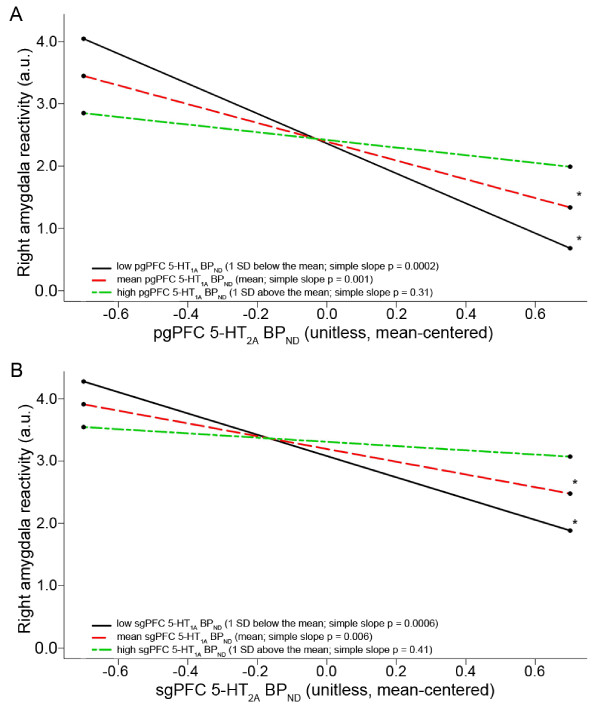
5-HT1A BPND significantly moderated the correlation between 5-HT2A BPND and right amygdala reactivity. (A) pgPFC 5-HT1A BPND moderated the correlation between pgPFC 5-HT2A BPND and right amygdala reactivity. Lines indicate simple slope between pgPFC 5-HT2A BPND and right amygdala reactivity at three arbitrarily chosen pgPFC 5-HT1A BPND values: low (1 SD below mean (-1 SD), solid black line), mean (equivalent to mean, red dotted line) and high (1 SD above mean (+1 SD), green dotted line). (B) sgPFC 5-HT1A BPND significantly moderated the association between sgPFC 5-HT2A BPND and right amygdala reactivity. Lines indicate simple slope between sgPFC 5-HT2A BPND and right amygdala reactivity at three arbitrarily chosen sgPFC 5-HT1A BPND values: low (-1 SD, solid black line), mean (red dotted line) and high (+1 SD, green dotted line). *Indicates simple slope, P < 0.05; 5-HT = serotonin; a.u. = arbitrary units; BPND = binding potential, non-displaceable; pgPFC = pregenual prefrontal cortex; sgPFC = subgenual prefrontal cortex.